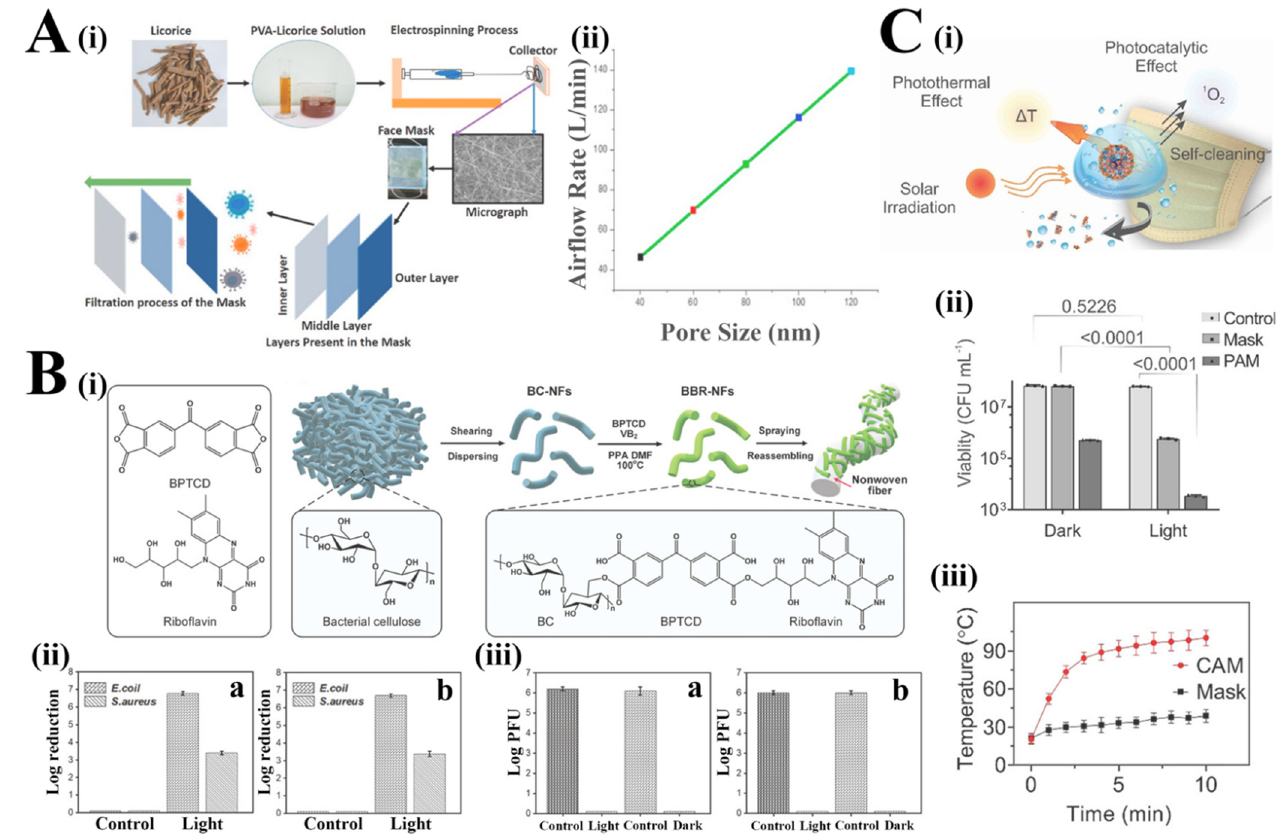
Figure 2. ( Ai ) Schematic illustration of the production of biobased antiviral face mask by electrospinning process. ( Aii ) Estimated airflow rate through the licorice membrane with a varying pore size [97]. ( Bi ) Schematic illustration of the fabrication of BBR-NFs and their encapsulation with the nonwoven fibers. ( Bii ) E Bactericidal activity of BBR@protective suit against E. coli and S. aureus under visible light irradiation ( a ) and dark conditions ( b ). ( Biii ) Viricidal assay against T7 phage for BBR@protective suit ( a ) and BBR@mask ( b ) under visible light irradiation and dark conditions [99]. ( Ci ). Schematic illustration of the virus inactivation in respiratory droplets through photothermal, photocatalytic and hydrophobic self-cleaning processes under solar irradiation. ( Cii ). Colony-forming unit (CFU) number of viable E. coli after solar illumination treatment on the surface of the control, PAM and raw surgical mask (data are presented as means ± SD and n = 3). ( Ciii ). Increase in the CAM and Mask surface temperature as a function of solar illumination time (data are presented as mean ± SD and n = 3) [101].